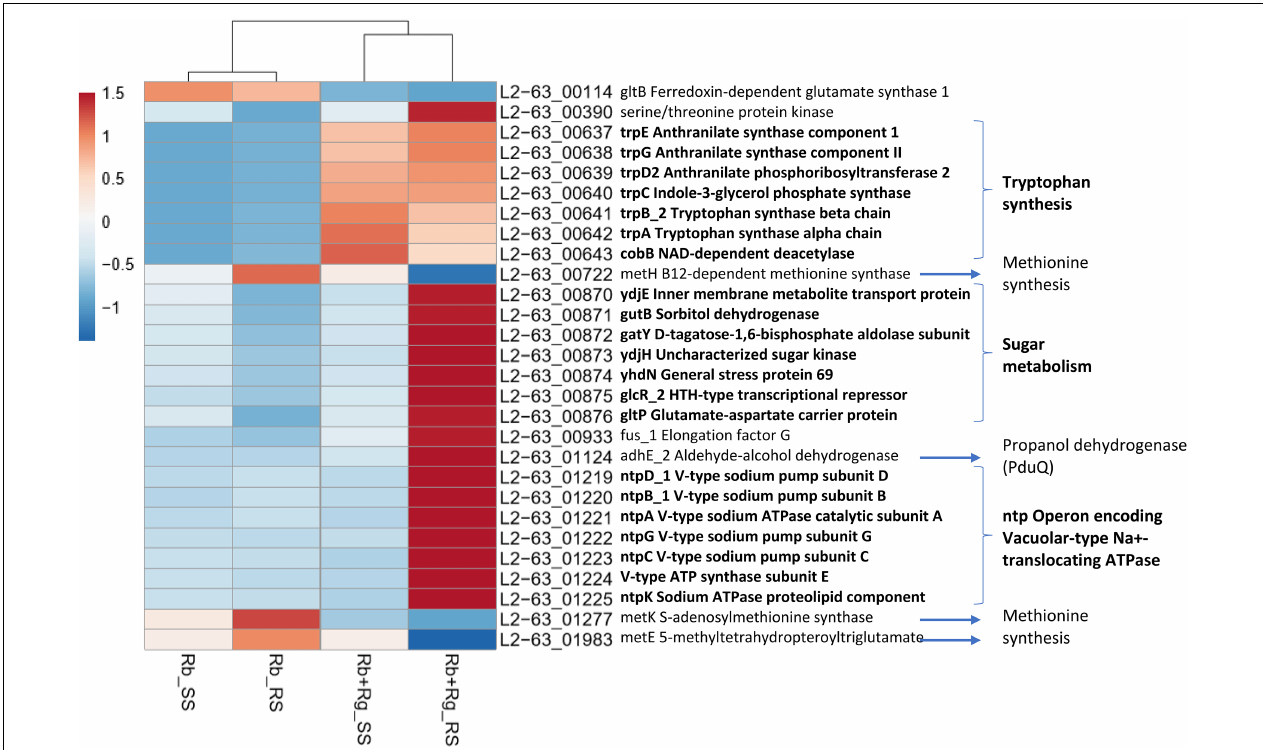
FIGURE 6 | Heatmap of the transcription level (in arbitrary unit) of differentially expressed (Log2 Fold Change < –1.5 or > 1.5 and padj < 0.05) R. bromii L2-63 genes in different growth conditions. This heatmap was produced with ClustVis web tool (Metsalu and Vilo, 2015) using the transcript counts as input